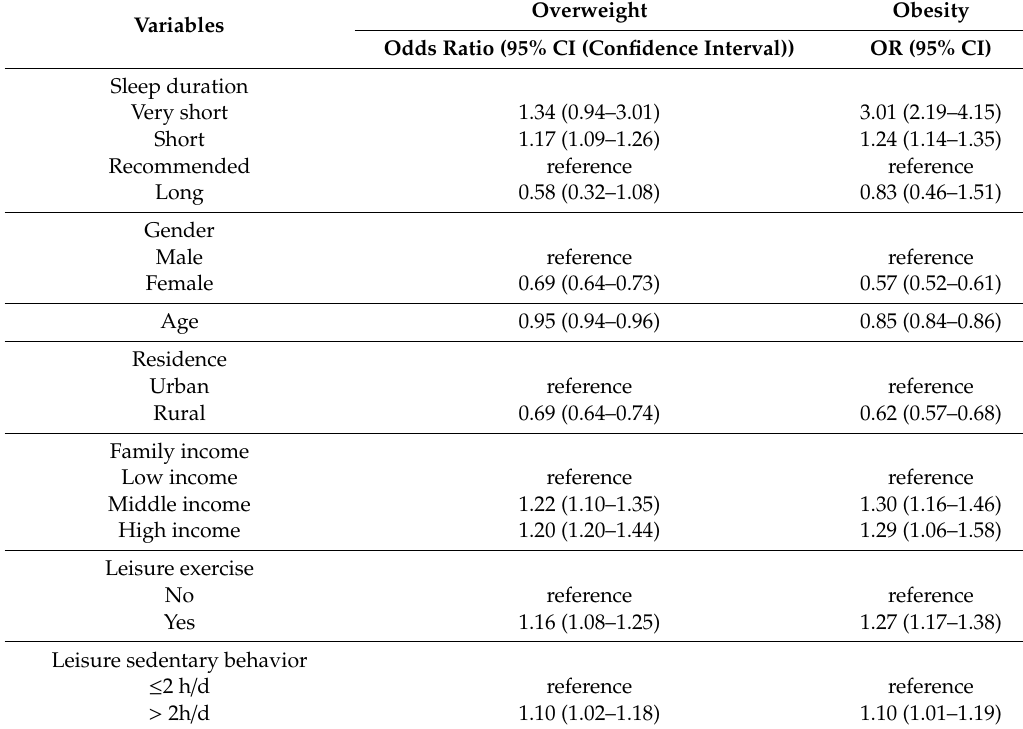
Table 2. Multivariate logistic regression analysis of sleep duration and overweight and